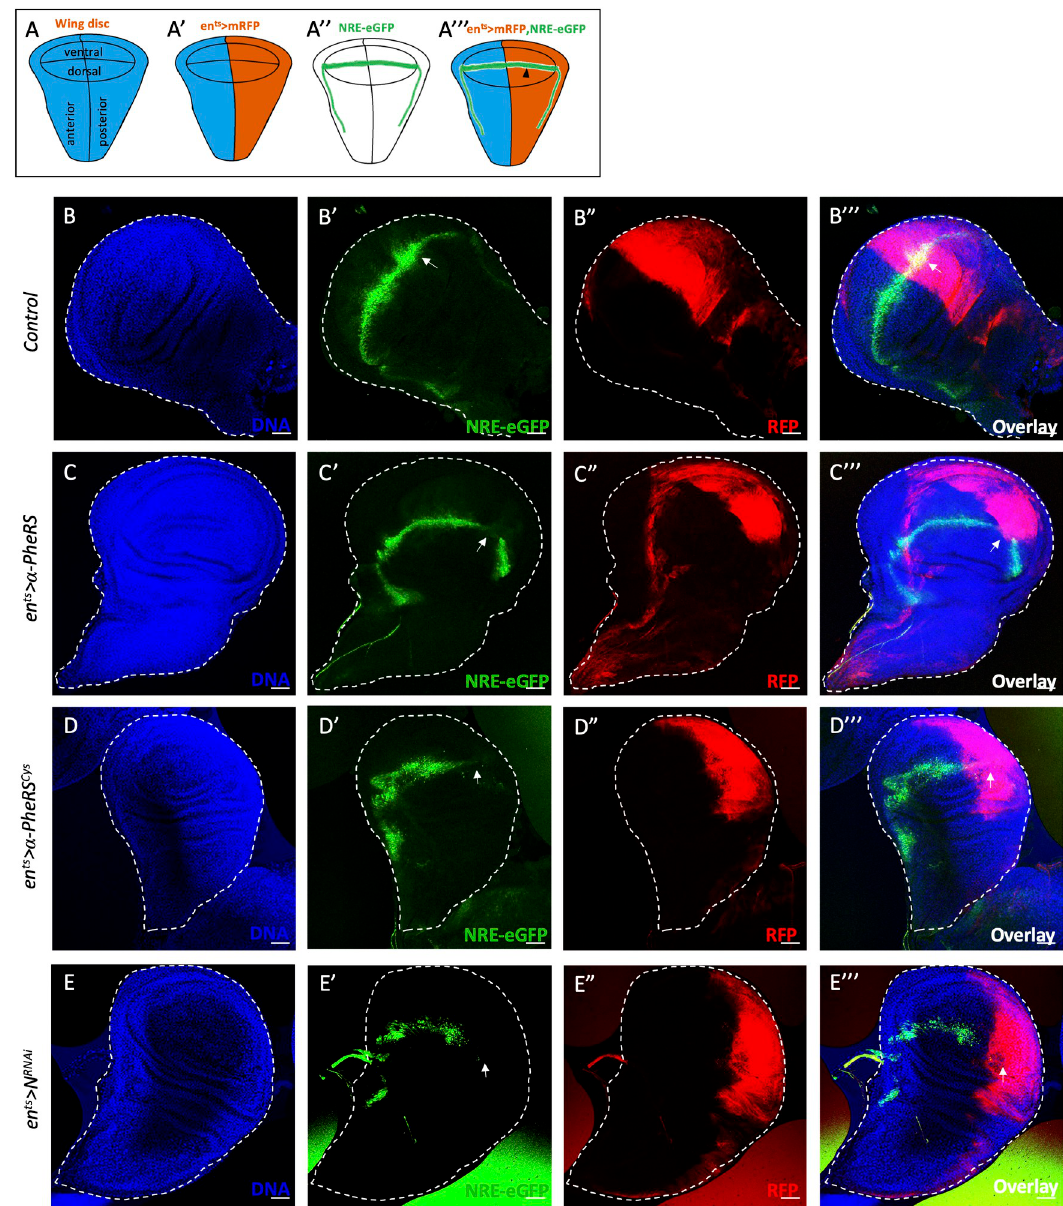
Fig 5. Elevated α -PheRS levels repress Notch signaling in wing discs. Schematic illustration of wild-type wing imaginal discs showing the position of the different compartments (A), the expression domain of en ts > mRFP (A’), and the expression domain of NRE-eGFP (A”) along the dorsal/ventral (D/V) boundary. (A”’) en-Gal4 , NRE-eGFP , UAS-mRFP;tub-Gal80 ts was used to drive transgene expression in the posterior compartment of developing wing discs and to evaluate the Notch activity with the reporter NRE-eGFP (black arrowhead) (w , UAS-Dcr2/+;en-Gal4 , UAS-mRFP , NRE-eGFP/+;tub-Gal80 ts /UAS- α -PheRS (Cys) ) . (B-E”’) Elevated α - PheRS or α -PheRS Cys led to the loss of NRE-eGFP expression in the posterior compartment, similar to the phenotype of Notch knockdown (w , UAS-Dcr2/UAS-N RNAi ;en-Gal4 , UAS-mRFP , NRE-eGFP/+;tub-Gal80 ts /+) . After egg-laying and incubation at 18˚C for 6 days, the animals were shifted to 29˚C for 1 day to inactivate Gal80 ts and to enable expression of α -PheRS, α -PheRS Cys , or N RNAi . gene (Fig 6B). Expressing α -S with the en-Gal4 driver and staining wing discs for Myc, revealed that this truncated version of α -PheRS was stably expressed in the posterior wing disc compartment (S2 Fig). To test whether this C-terminally truncated isoform was able to repress